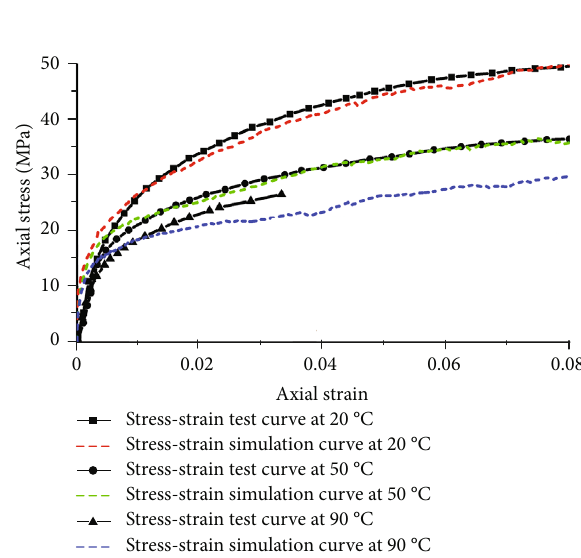
Figure 4: Stress-strain curves of di ff erent temperatures under the con fi ning pressure of